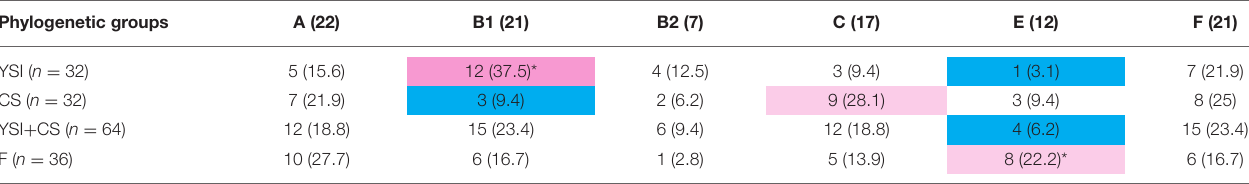
TABLE 3 | Phylogenetic distribution of avian Escherichia coli strains isolated from yolk sac infection, coliseptocemia, and fecal samples. Phylogenetic